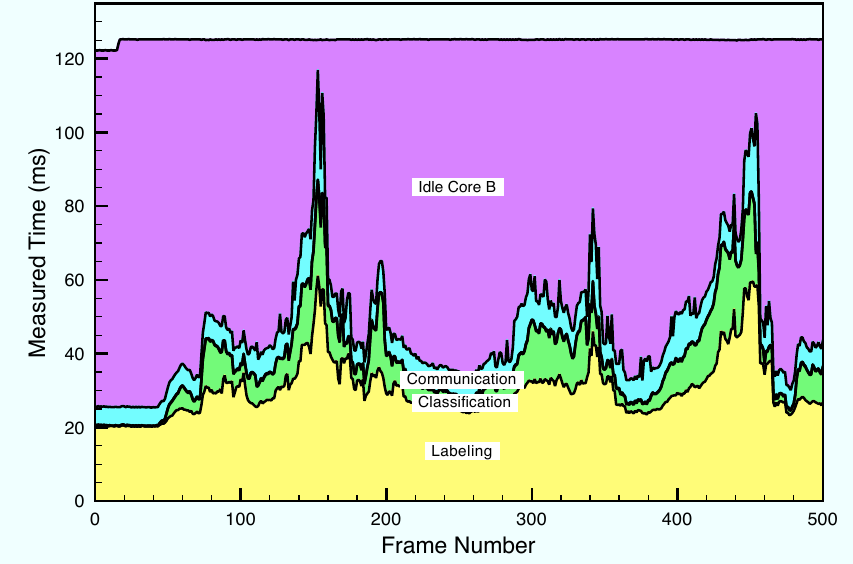
Figure 12. Measured times of each phase of video processing running in Core B, including the idle time. The data are represented stacked. The different areas are labeled with the corresponding phase of